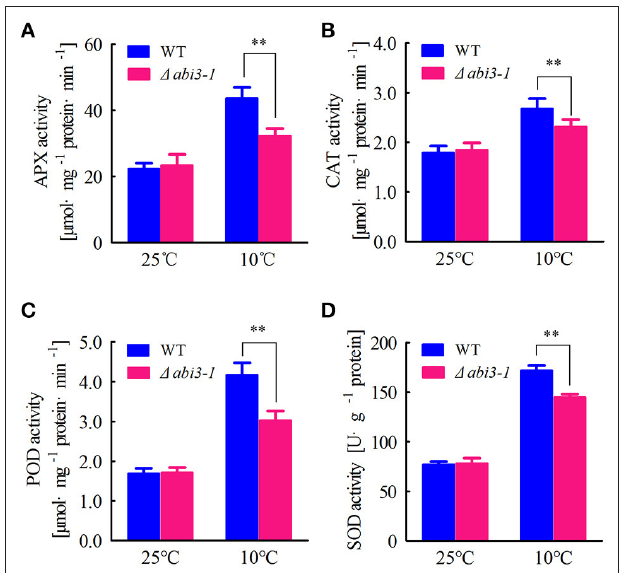
FIGURE 4 | Expression of antioxidant enzymes mediated by PpABI3 during cold acclimation. (A–D) The transcriptional levels of genes encoding ascorbate peroxidase (APX: Pp1S277_34V6), catalase (CAT: Pp1S422_8V6), glutathione peroxidase (POD: Pp1S98_2V6) and superoxide dismutase (SOD: Pp1S22_320V6) were analyzed by quantitative RT-PCR in wild-type and ∆ abi3-1 with or without cold acclimation. Error bars represent SD ( n = 3), and two-way ANOVA was used to determine the statistical significance (** P < 0.01; *** P < 0.001).